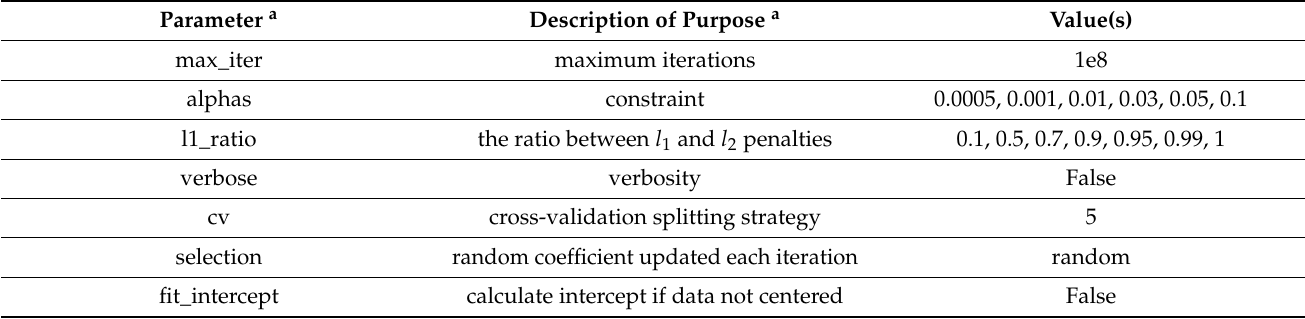
Table 4. User-defined parameters for elastic net regularization using ElasticNetCV from the scikit-learn library. The remaining parameters were default.